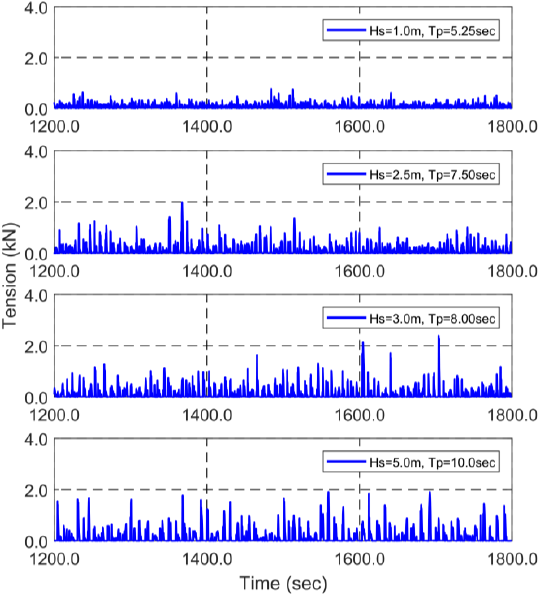
Figure 11. Time histories of rope tension in different wave conditions under identical current velocity ( V c = 1.0 m/sec).